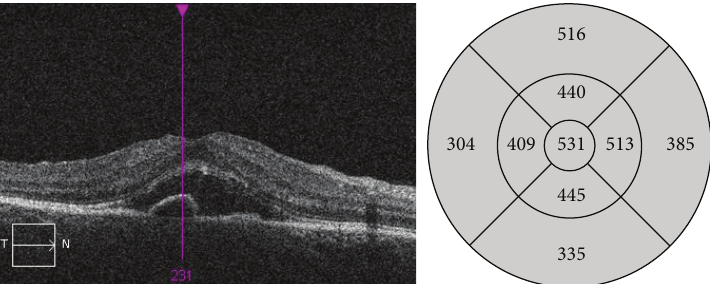
Figure 2: OCT scan 2 days after SDM treatment: large amount of subretinal fluid present as well as persistent small PED. Increase in the thickening of the sensory